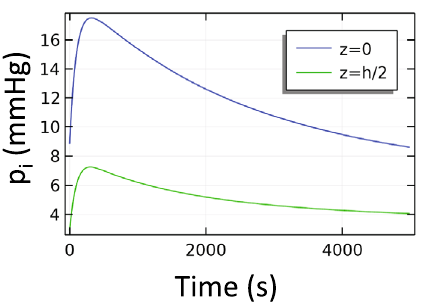
Figure 8. Transient multi-layer model with compression. Beginning with an initial condition in which venous insufficiency produced swelling near the ankle (z = 0), a compression wrap (0 < z < h/2) was applied gradually over the first 100 s. At the last time point shown, the IFP is still relaxing to its steady state value. The time scale here is dominated by the vascular absorption